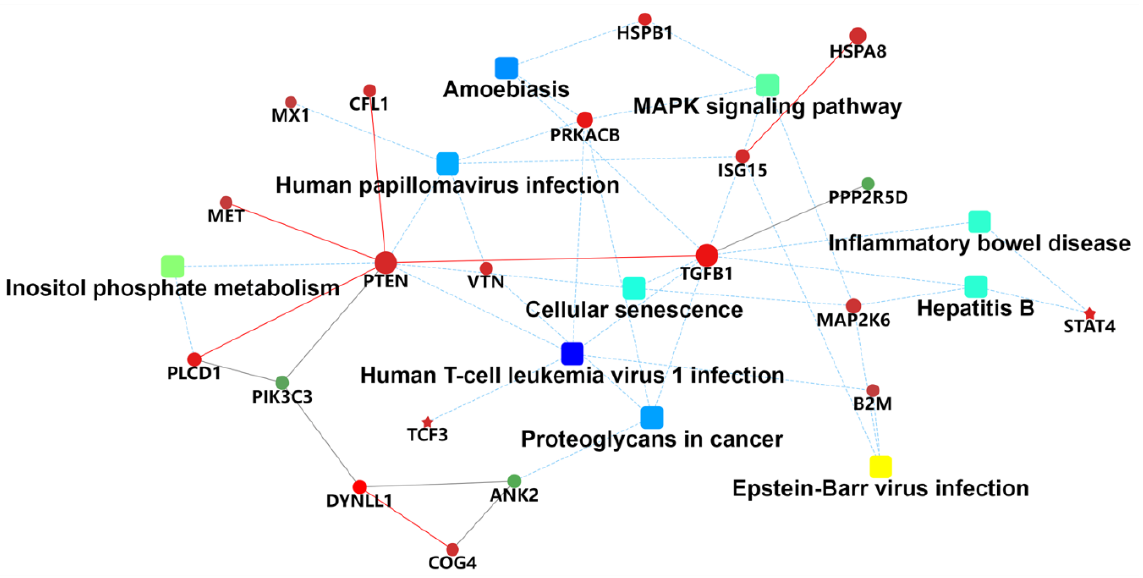
Figure 8. Analysis and enrichment results of KEGG pathways and protein-protein interaction (PPI) in SW1990 cells treatment with G-6 10 µM for 24 h. The PPI analysis was based on fold change of protein, protein-protein interaction, KEGG pathway enrichment and biological process enrichment. Circle nodes refer to proteins. Rectangle refers to KEGG pathway or biological process, which were colored with gradient color from green to red (low-high fold change).